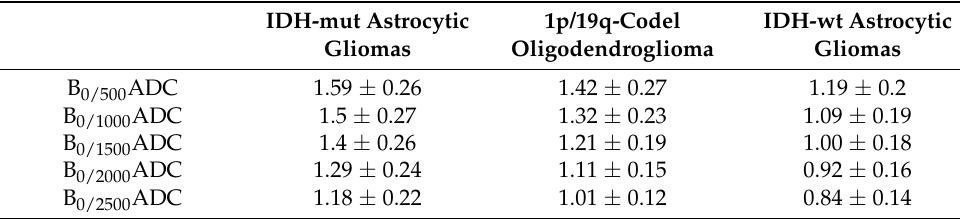
Table 1. B 0 -avADC values of the three glioma subgroups (10 − 3 × mm 2 /s).